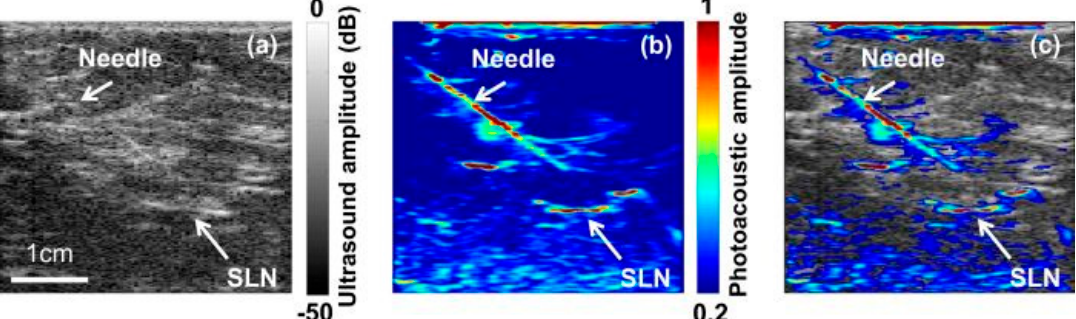
Figure 3. Comparison of PA, US and dual mode PA-US images of SNL showing the lymph node and needle. ( a ) US image, ( b ) PA image, and ( c ) co-registered PA-US image. Reproduced from Garcia-